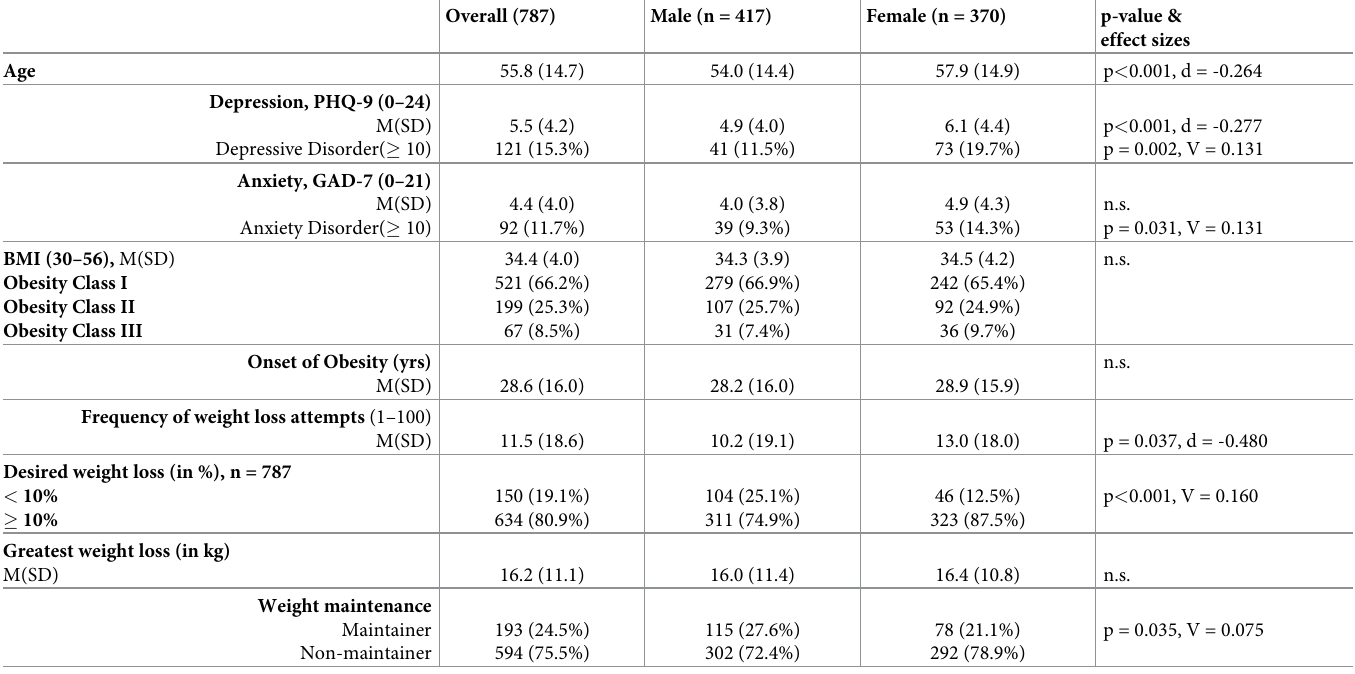
Table 1. Sociodemographic information for the overall sample and separated by